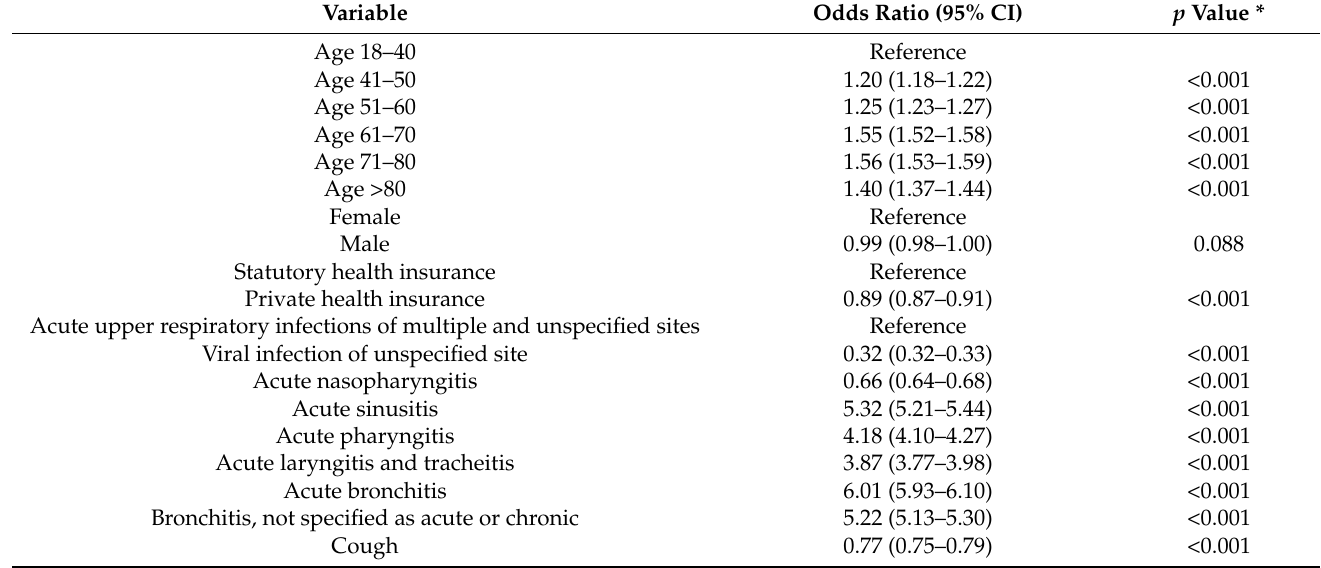
Table 3. Variables associated with an antibiotic prescription in patients diagnosed with an acute lower or upper respiratory tract infection in